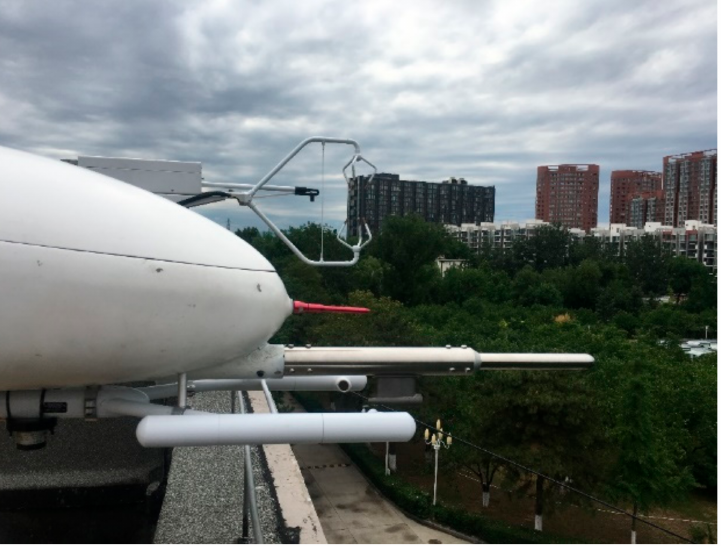
Figure 3. The ground-based comparison experiment between 1:00 and 6:00 p.m. on 31 May 2020 at the ChineseResearchAcademyofEnvironmentalSciences(CRAES)inBeijing(40 ◦ 2 (cid:48) 27.51 (cid:48)(cid:48) N, 116 ◦ 24 (cid:48) 45.54 (cid:48)(cid:48) E) with a measurement height of 10.3 m above the ground